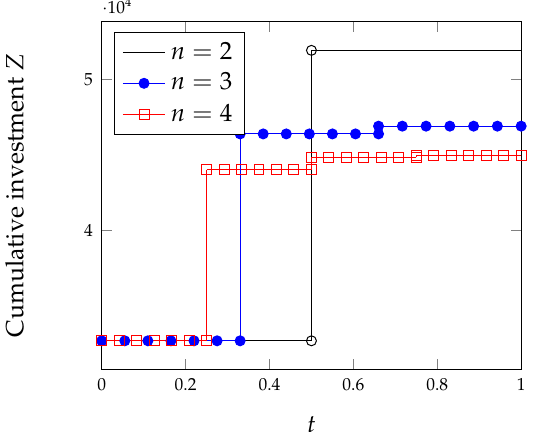
Figure 9. Optimal cumulative expense E under full liability and GL2 model.